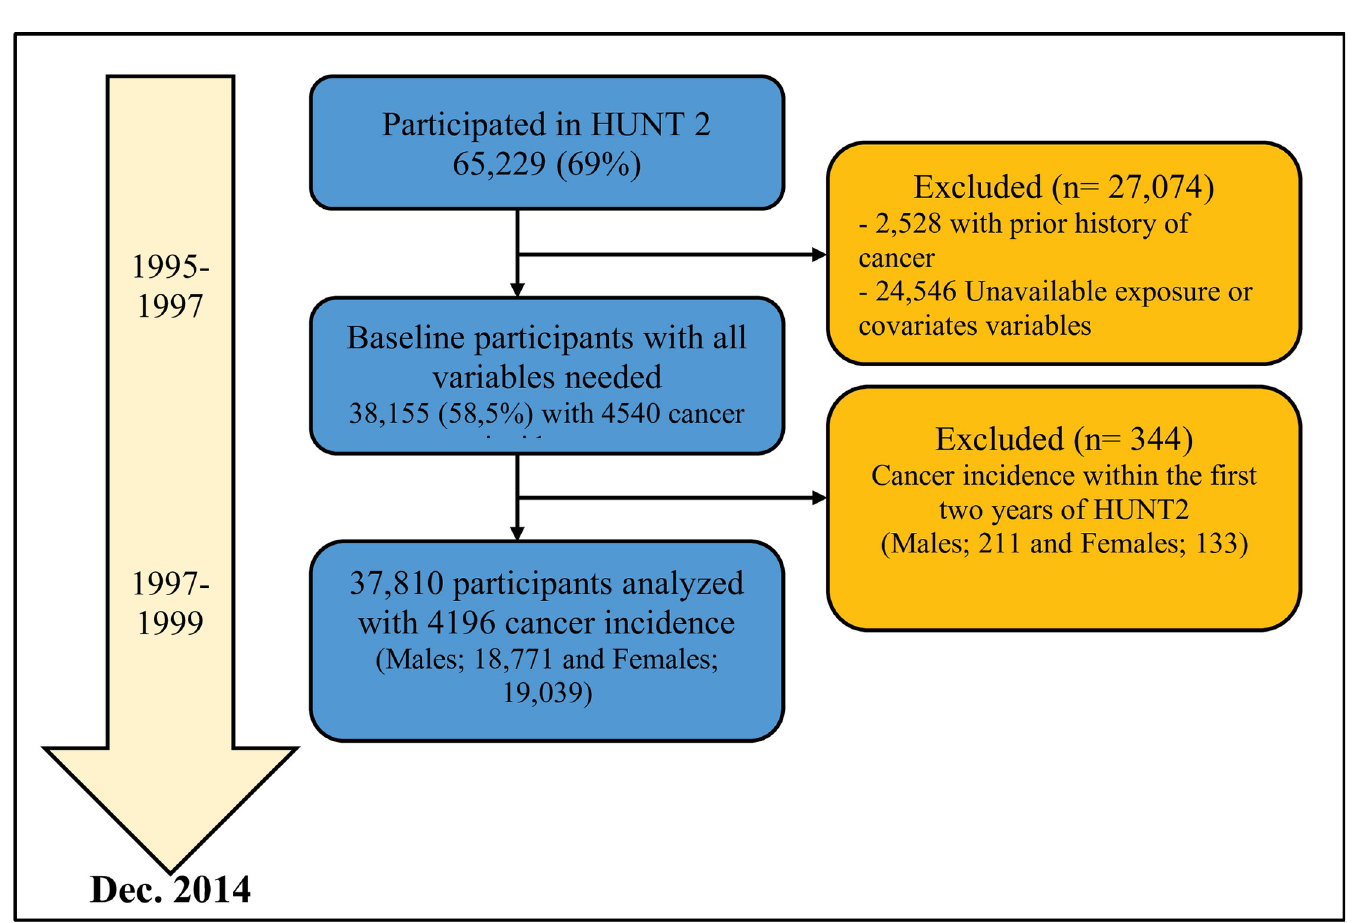
Fig 1. The study flowchart of inclusion over the